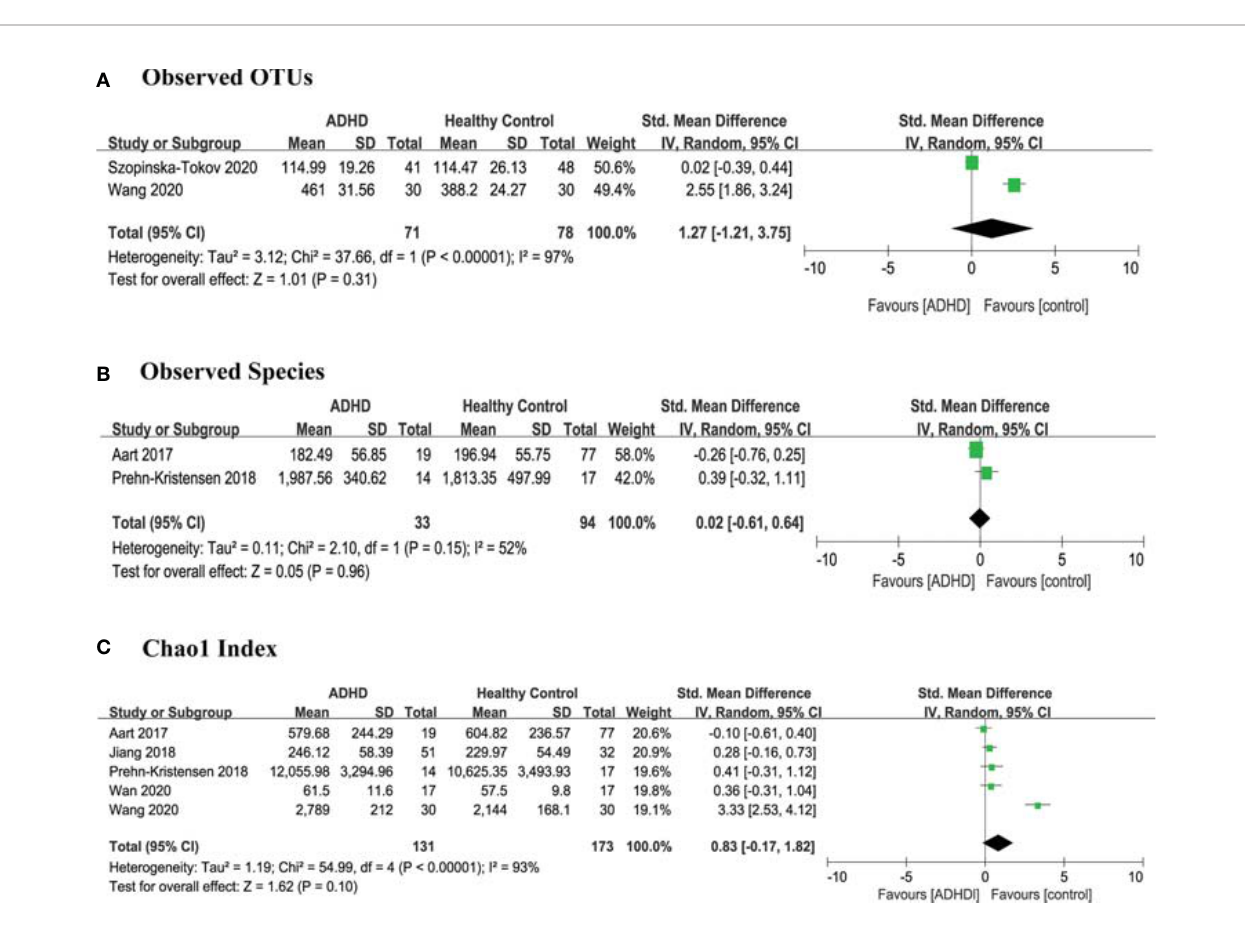
FIGURE 2 | Forest Plots of Alpha Diversity Richness Estimators in the Gut Microbiota of ADHD Compared with HCs. (A) Observed OTUs; (B) Observed Species; (C) Chao1 index. CI, con fi dence interval; SMD, standardized mean